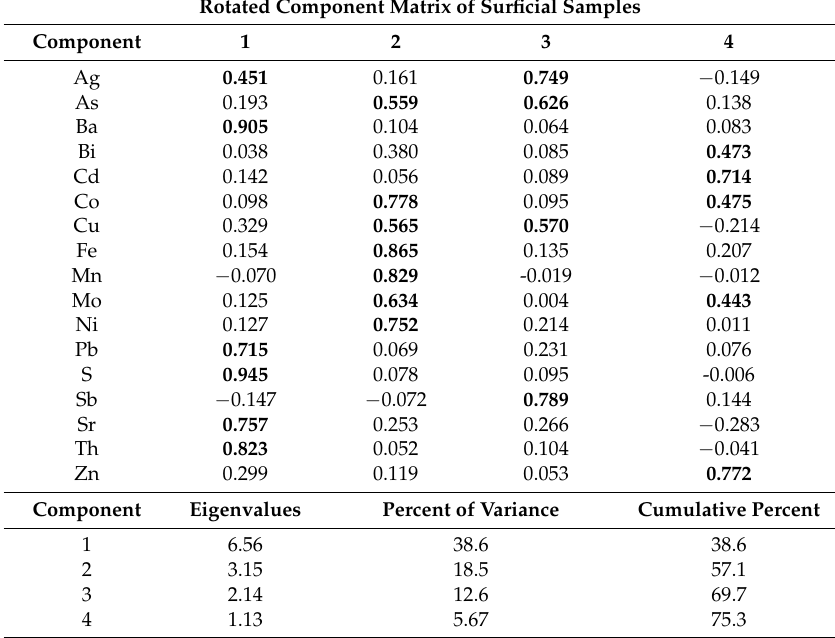
Figure 6. ( a ) Scree plot of parallel analysis (eigenvalues Mont-Carlo simulation) using PCA on CLR from the surface samples in Block A of the Ravanj deposit. Eigenvalues upper than raw data line are significant; ( b ) Biplot of PC1 vs. PC2; ( c ) Biplot of PC2 vs. PC3; and ( d ) Biplot of PC3 vs. PC4. Table 4. Results of Robust PC analyses of surface samples from Block A of the Ravanj deposit (using the broken-stick method, [45]). Significant values are in bold. Only PCs with eigenvalues > 1 are displayed.